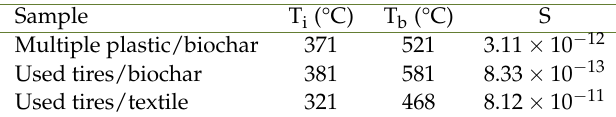
Fig. 4. Comparison of the TG-DTG curves of (a) multiple plastics/biochar (b) used tires/biochar (c) used tires/textile sample combinations. Table 2. Combustion parameters for different combinations of BSW at 20 °C ·min ˘1